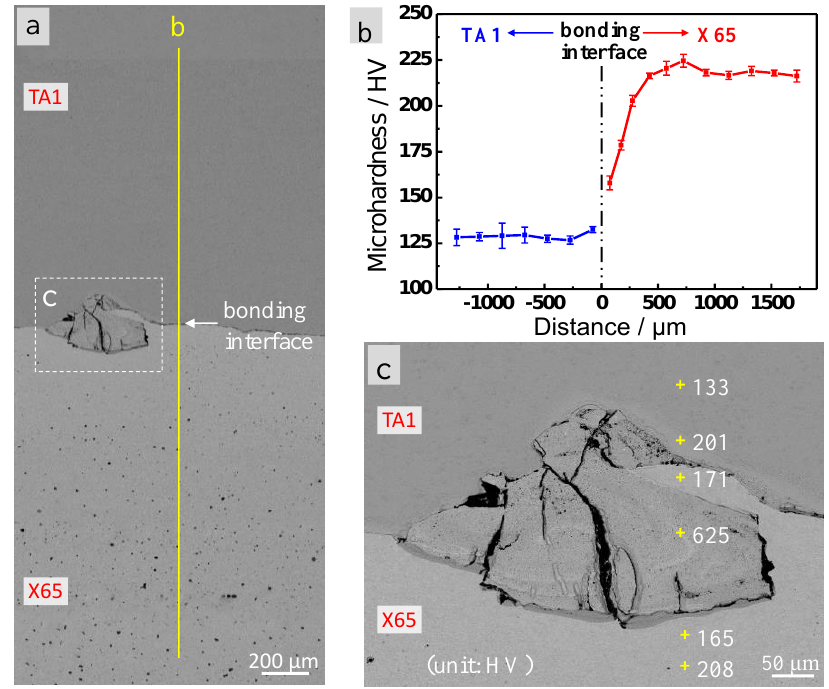
Figure 7. Microhardness profile across the interface of the TA1/X65 clad plate: ( a ) bonding interface; ( b ) microhardness; and ( c ) points microhardness.